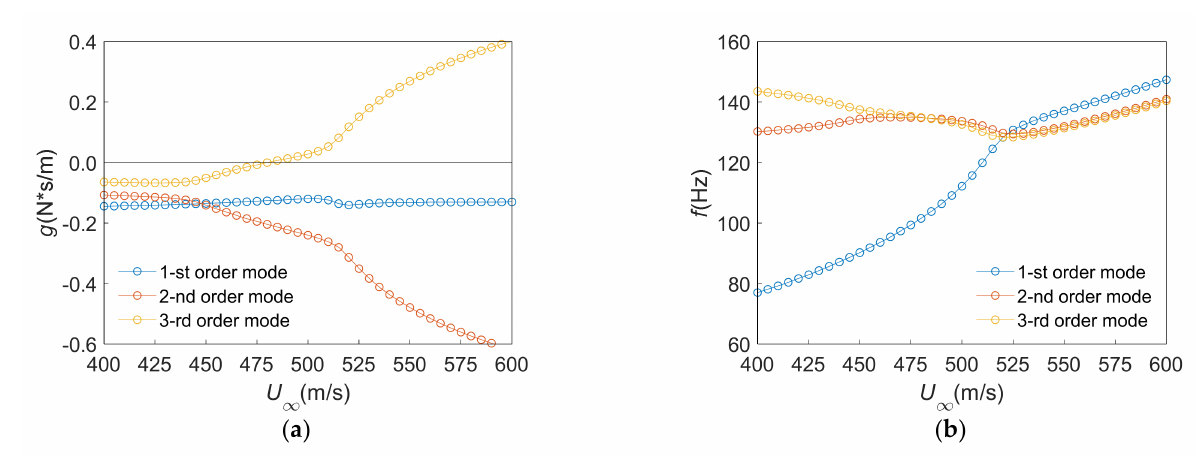
Figure 5. Results of flutter calculation (LR/LT): ( a ) U − g ; ( b ) U −